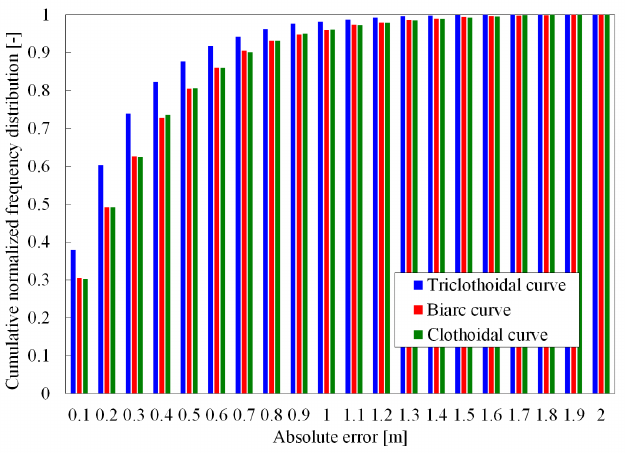
Figure 8. The comparison of the accuracy of trajectory prediction methods. More than 70% of the predictions by the Triclothoidal curve had less than 0.3 m of absolute error. Comparing to the other prediction methods, the Triclothoidal curve had a strong advantage for trajectory prediction at the intersection for